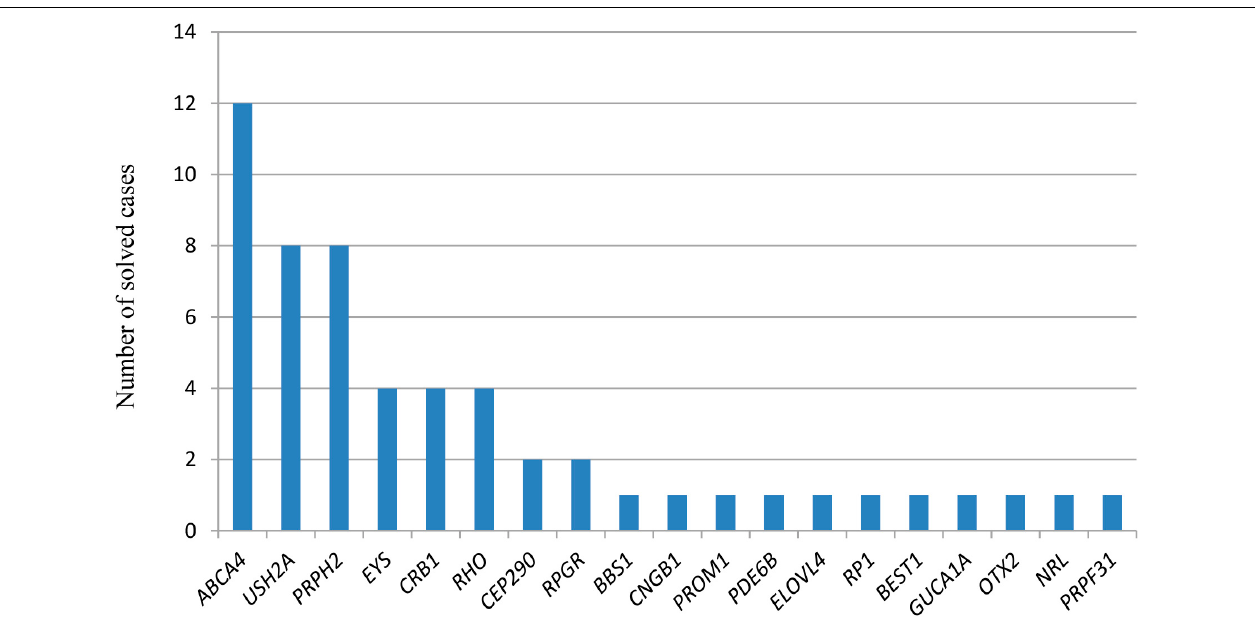
FIGURE 2 | Number of solved cases with mutations in the different disease-causing genes. The X-axis refers to the responsible genes for each solved case, and the Y-axis to the number of solved cases for each disease-causing gene. Only genes responsible for the disease are represented. For patient RPN-670 (FRPN-265), the three different possible responsible genes for the IRD are